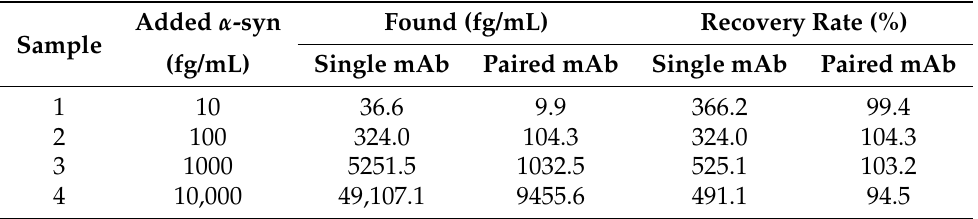
Table 3. Recovery rate of the single α -syn-RmAb and the paired α -syn-RmAb on SPR sensor.